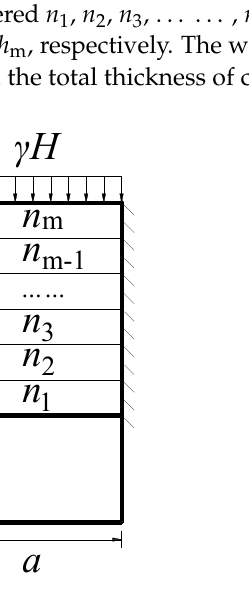
Figure 3. Mechanical structure model of composite roof.